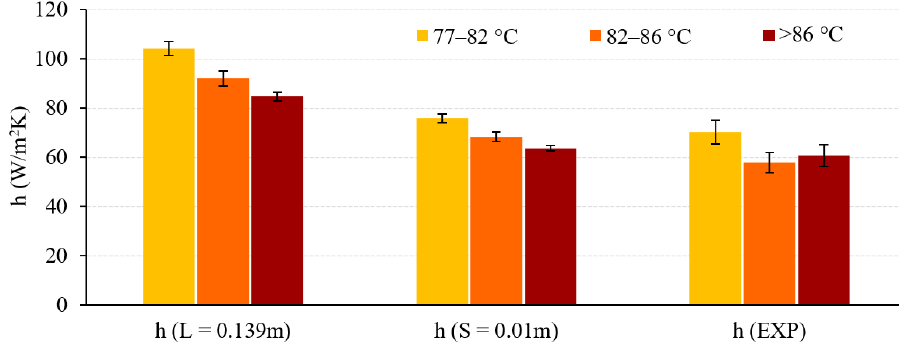
Figure 8. Comparison of average heat transfer coefficient (incl. standard deviation).